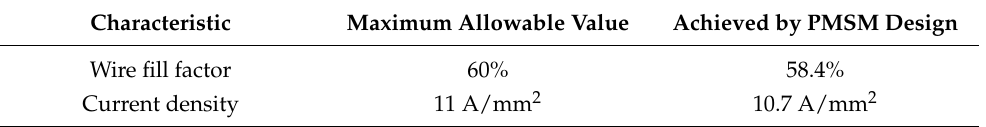
Table 2. Fill factor and current density